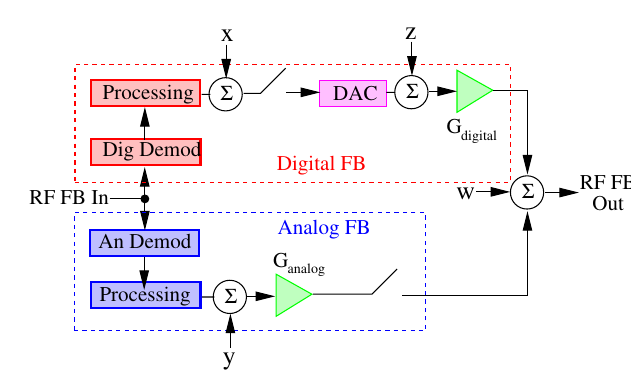
FIG. 13. Accelerating voltage phase power spectral density with controller gain setting from 4B2 (solid lines) and simulation (dashed lines). FIG. 14. The rf feedback block